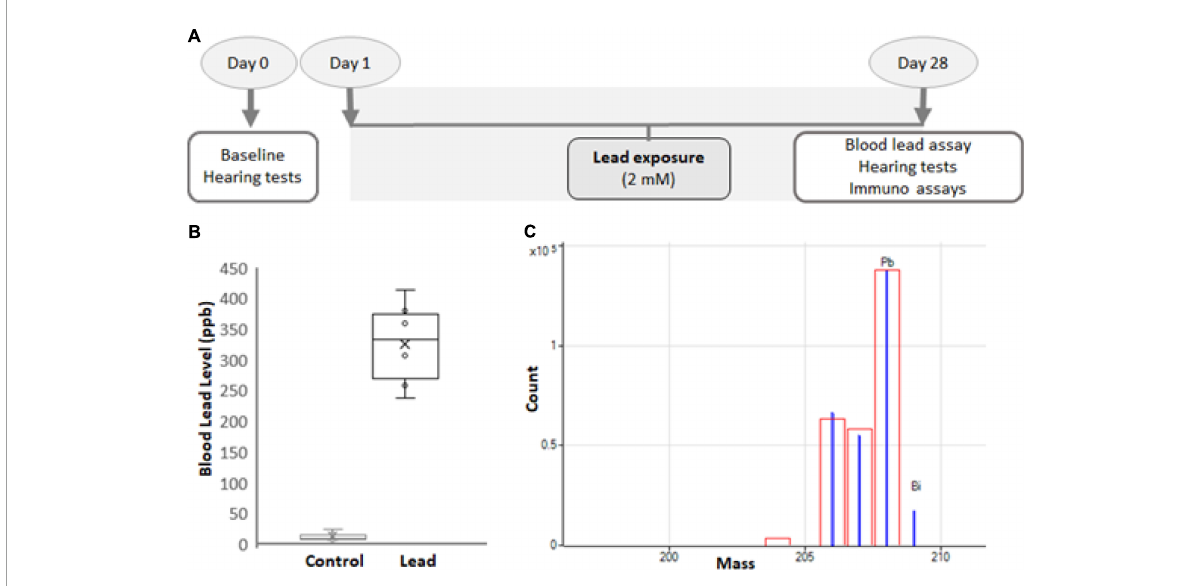
FIGURE1 Experimental design. (A) Five-week-old male C57BL/6 mice were exposed to 2 mM lead acetate in water for 28 days. Hearing thresholds, hair cell loss, ribbon synapse disruption, and nitrotyrosine levels in spiral ganglions were assessed for 1 day after the last exposure. Lead load was analyzed by assessing blood lead levels. (B) The blood lead levels in mice that consumed water containing 2 mM lead acetate for 28 days were 326 ± 70 ppb. The results are expressed as mean ± standard deviation, n = 6. (C) Blood lead levels were analyzed using inductively coupled plasma mass spectrometry (ICP-MS). The mass spectrum (blue) of Pb and Bi (internal) standards used in the ICP-MS analysis is illustrated. The red box indicates the isotopic